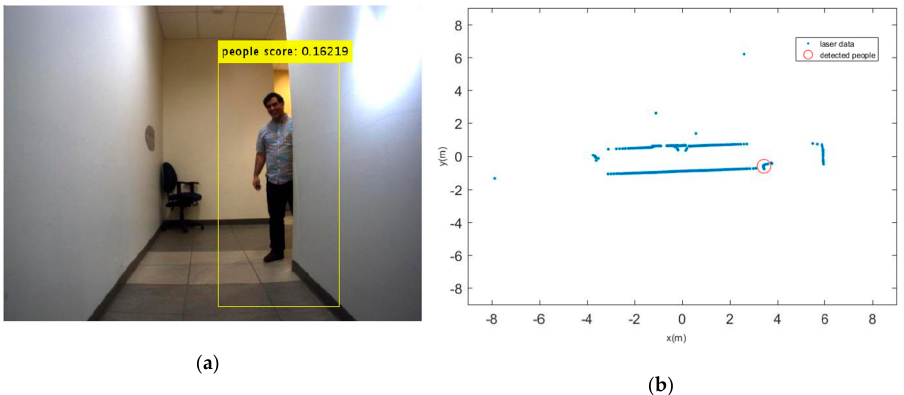
Figure 1. ( a ) Detected moving person; ( b ) His extracted depth from laser sensor.